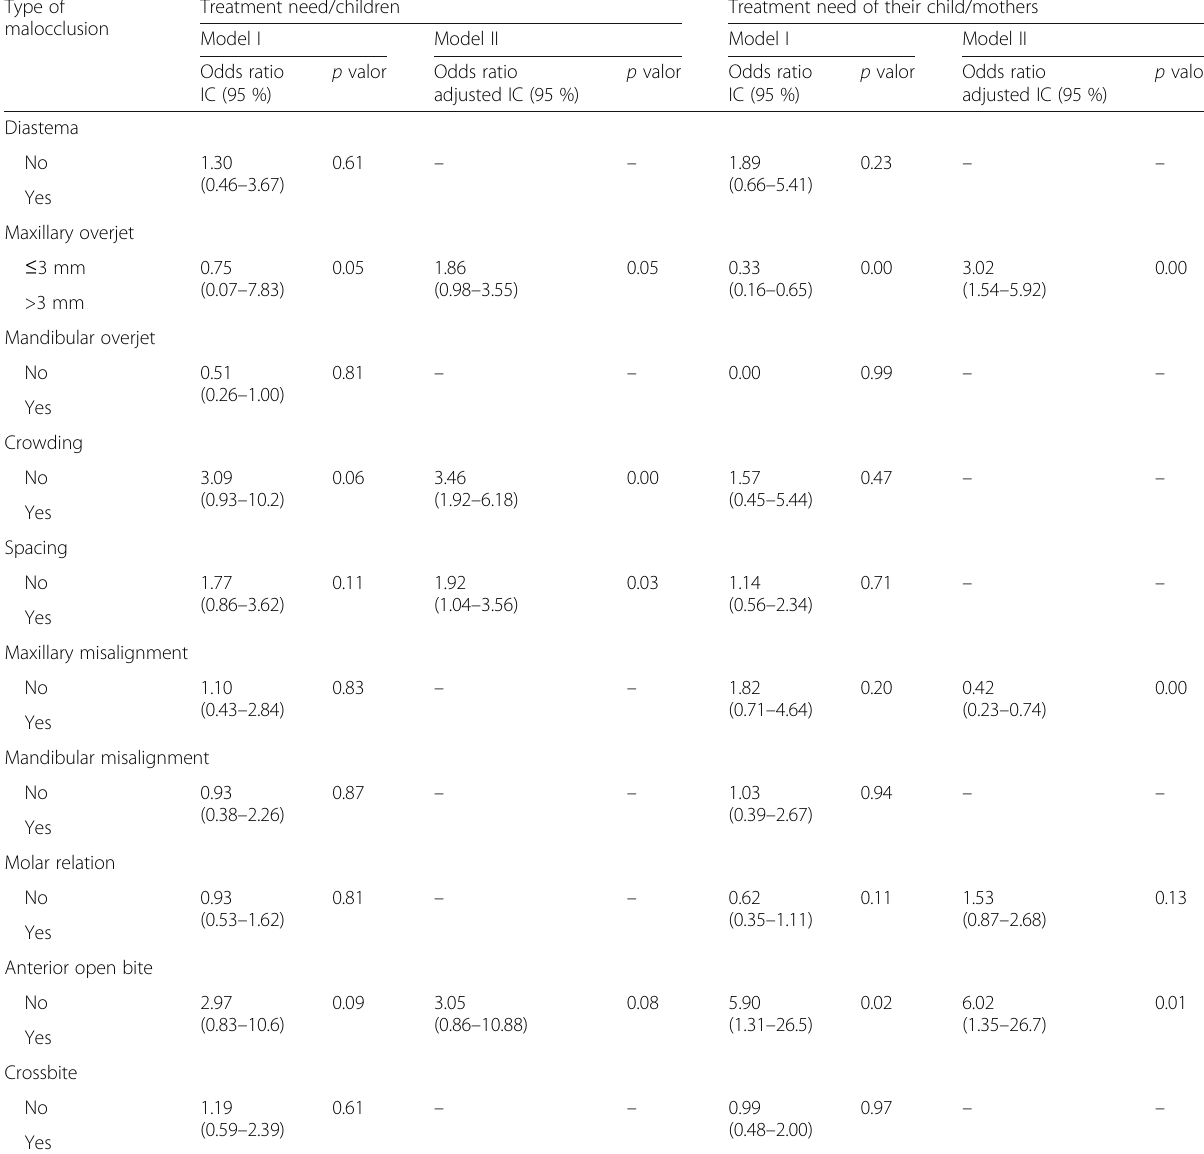
Table 2 Logistic regression of perception of orthodontic treatment need in children and their mothers and the types of